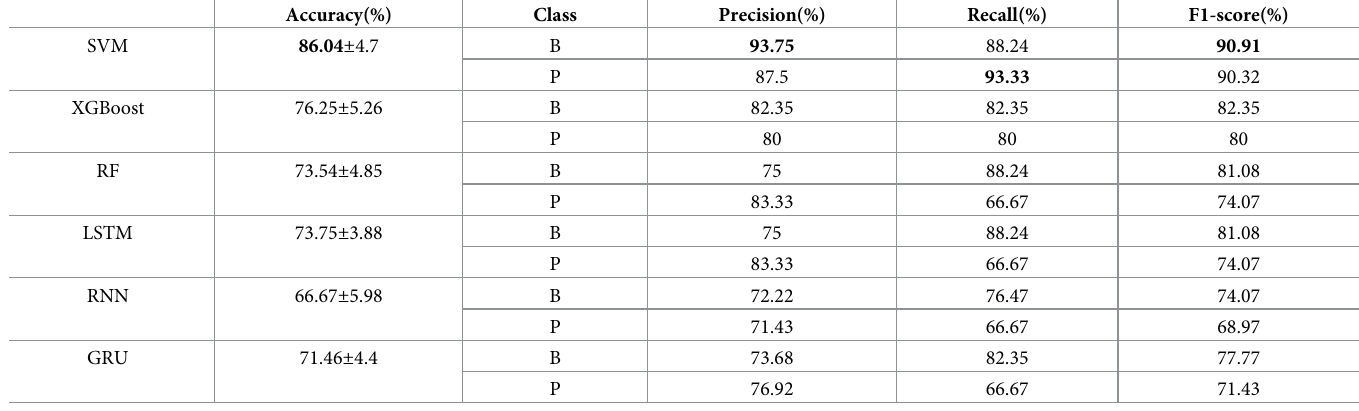
Table 4. Accuracy, precision, recall and F1-score comparison between SVM and contrast models on the RAW